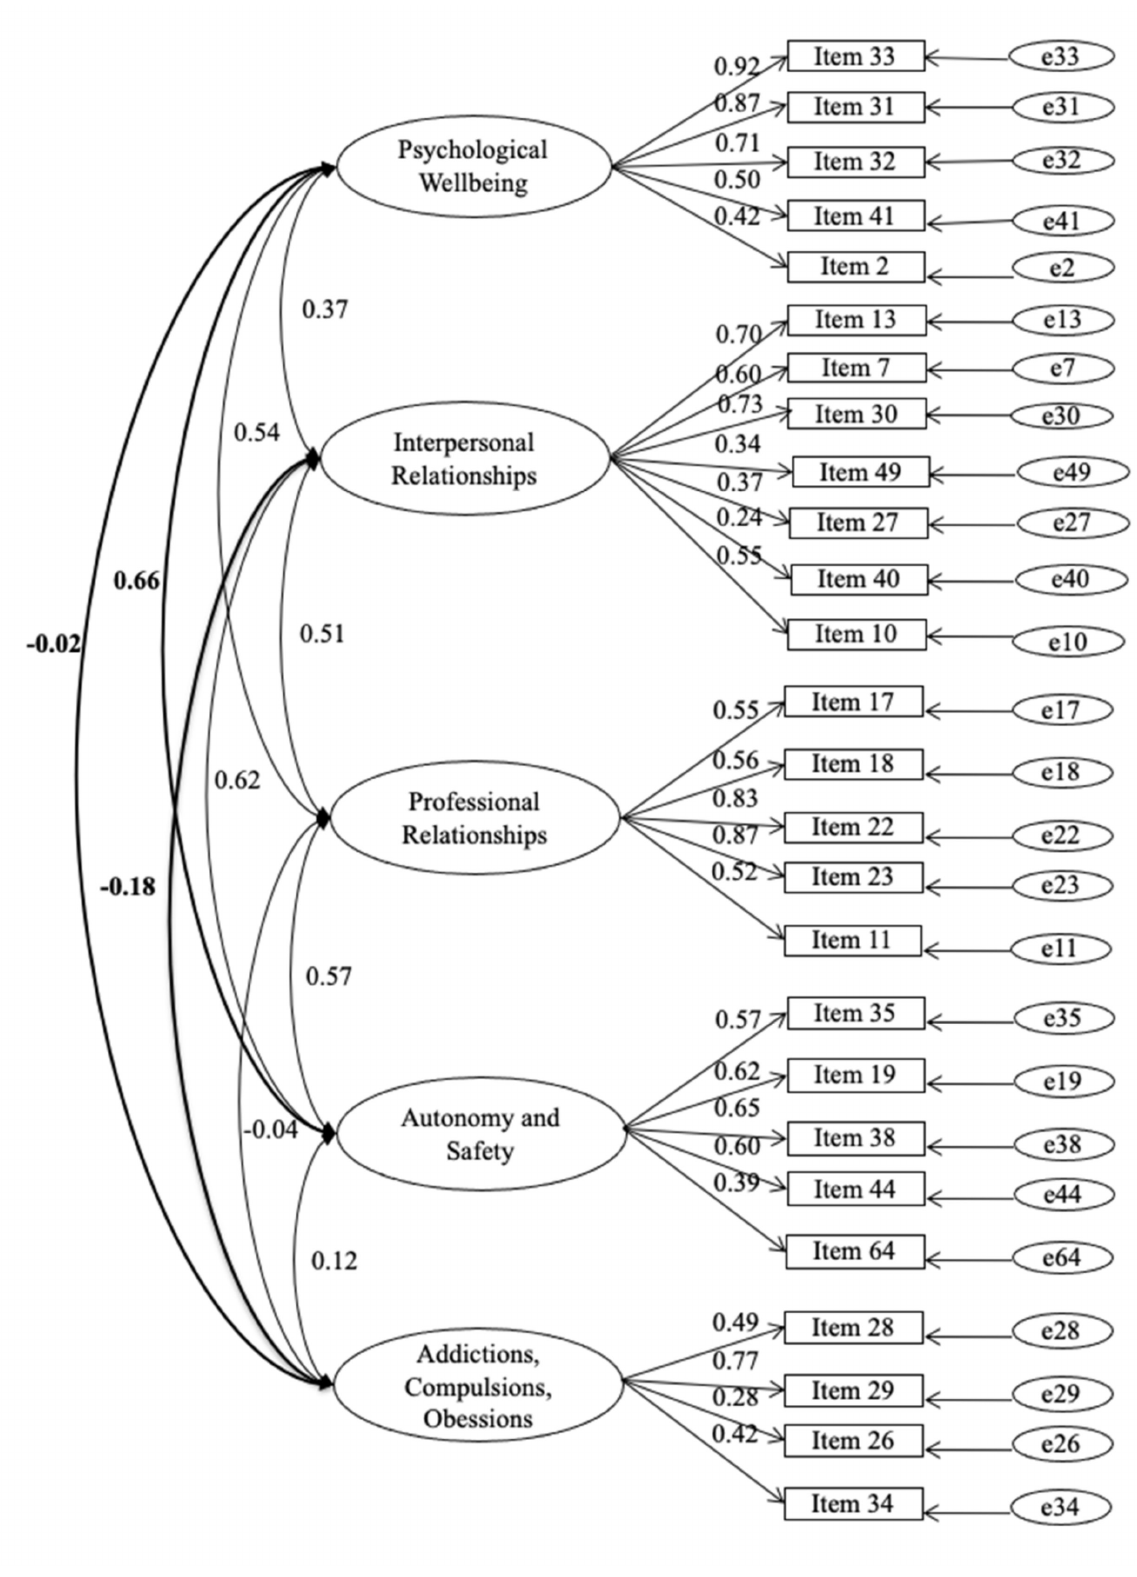
Figure 1. Five-Factor Model, Prosthetic Bionic Paradigm-Questionaire (PBP-Q), n =